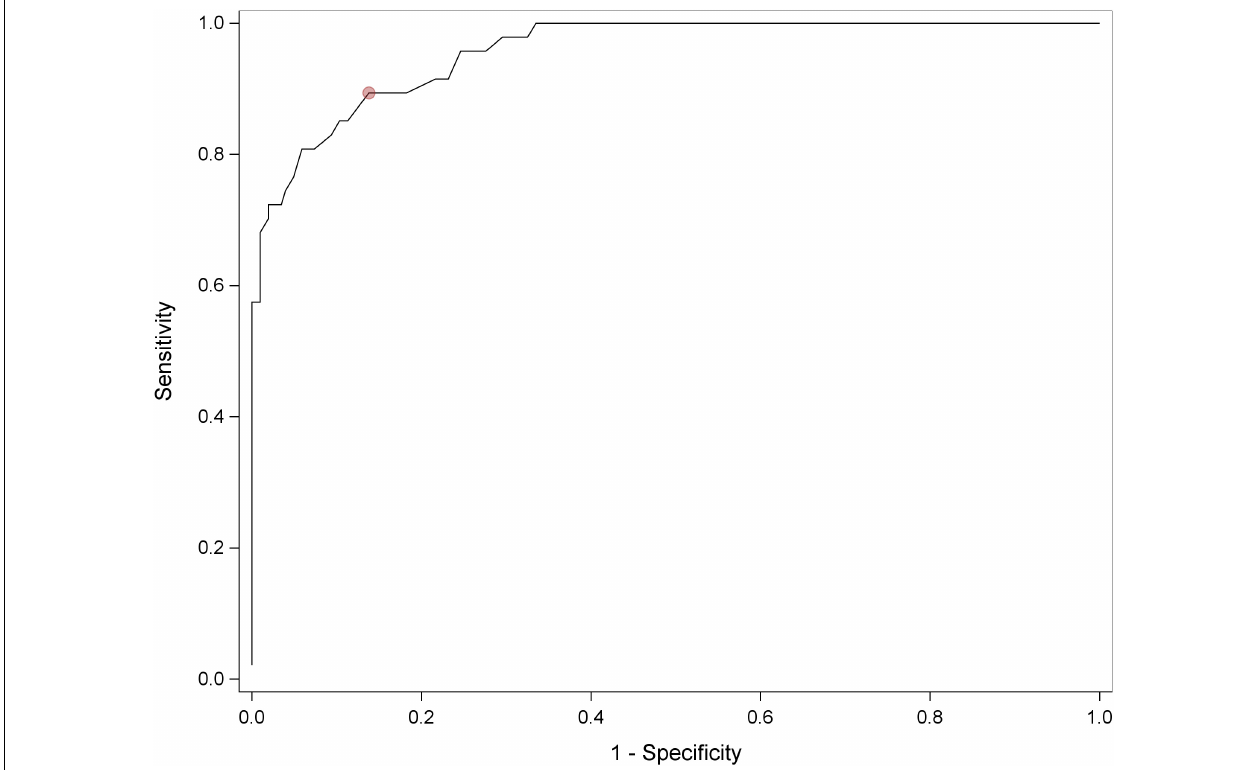
FIGURE 1 | Receiver operating characteristic curve for the IMAGE-HN for identifying clinically relevant HNC-related BID. Area under the curve = 0.96. The red dot represents the IMAGE-HN score that maximized sensitivity and specificity relative to a BIS score of ≥